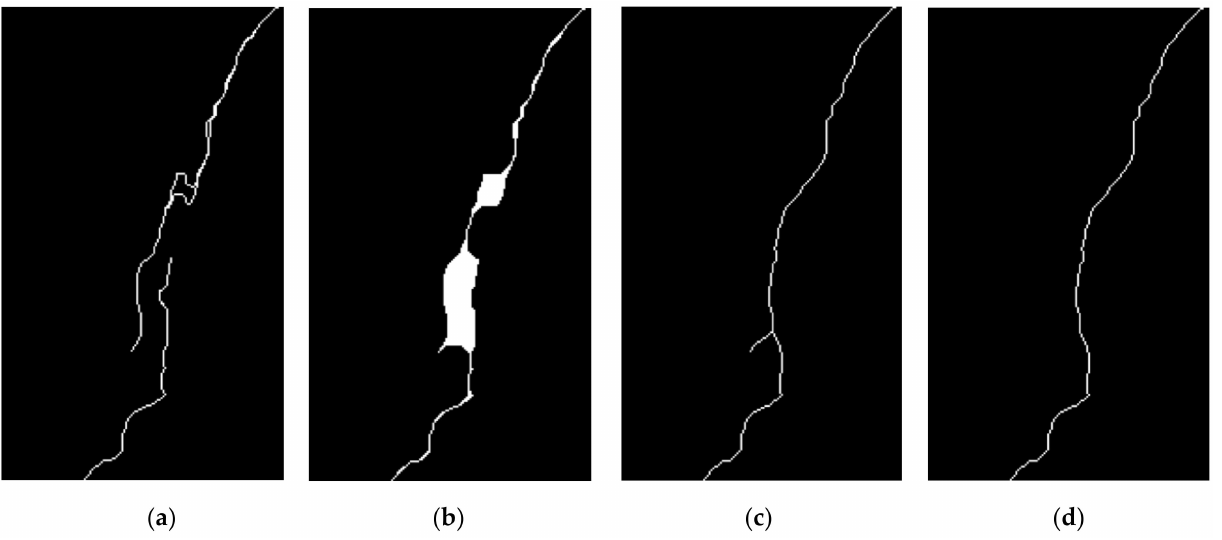
Figure 4. Post-processing of shorelines after U-Net detection. ( a ) overlapped shorelines; ( b ) shoreline after closing; ( c ) shoreline after thinning; ( d ) shoreline after